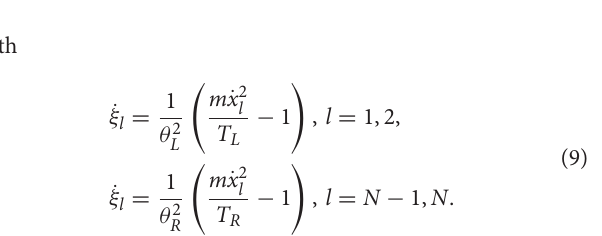
1 and T R 10. The lattice is strongly distorted in presence of temperature differences. (Right) Linear fit of max i ( = =